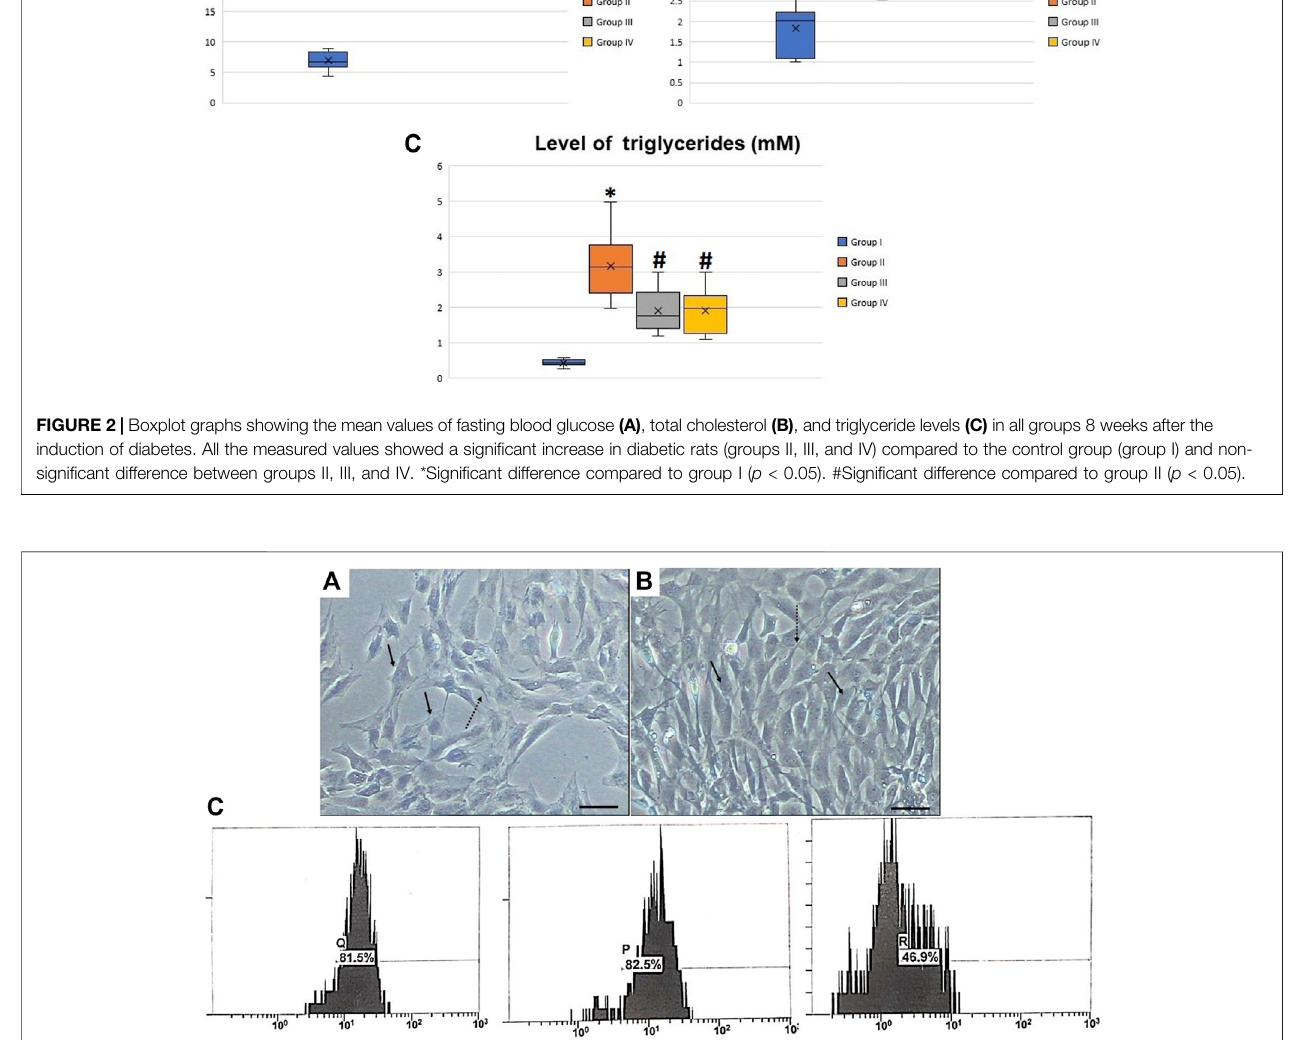
Frontiers in Physiology |